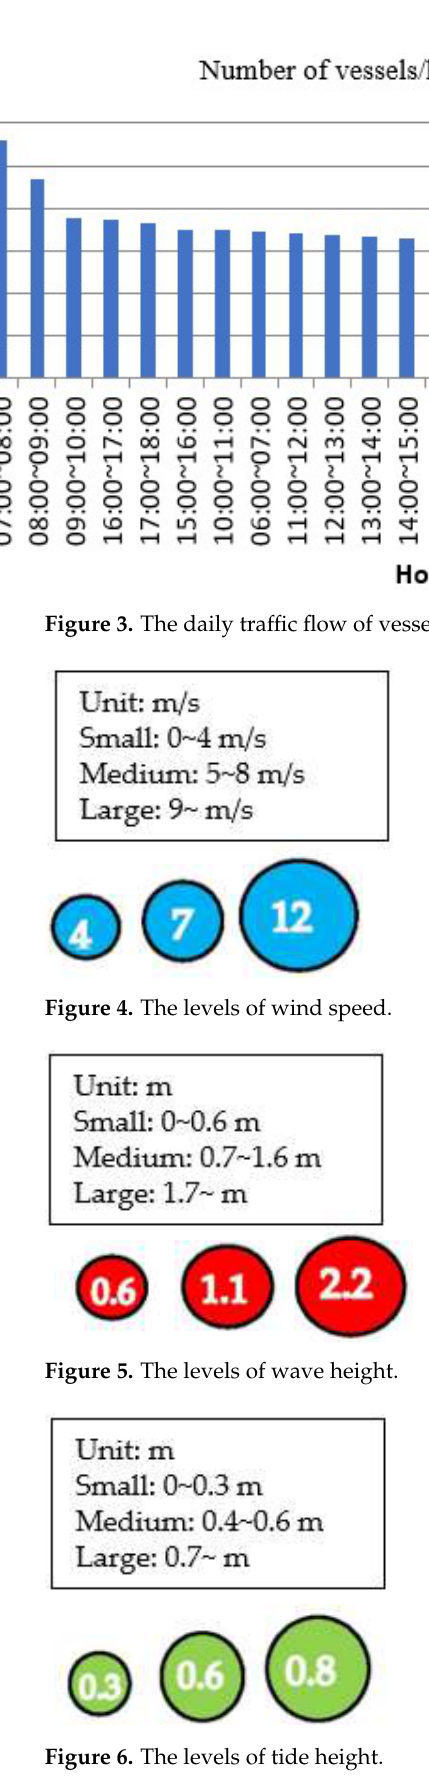
Figure 7. The levels of current speed.